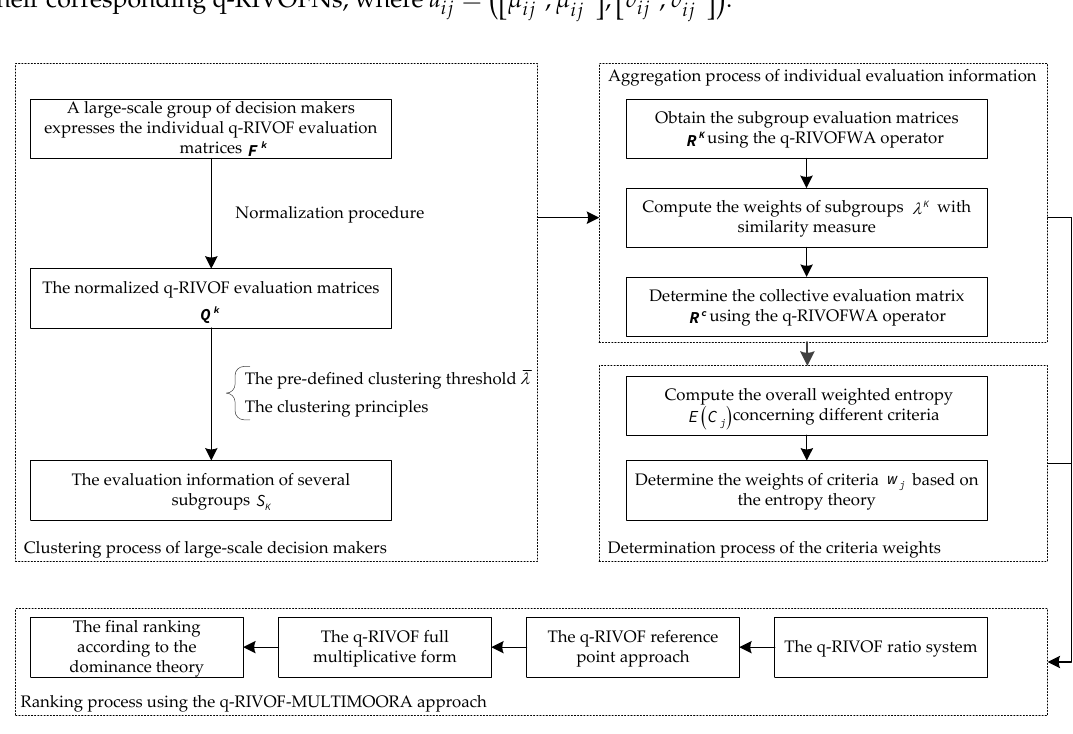
Figure 2. Flowchart of the proposed large-scale green supplier selection (GSS) approach.